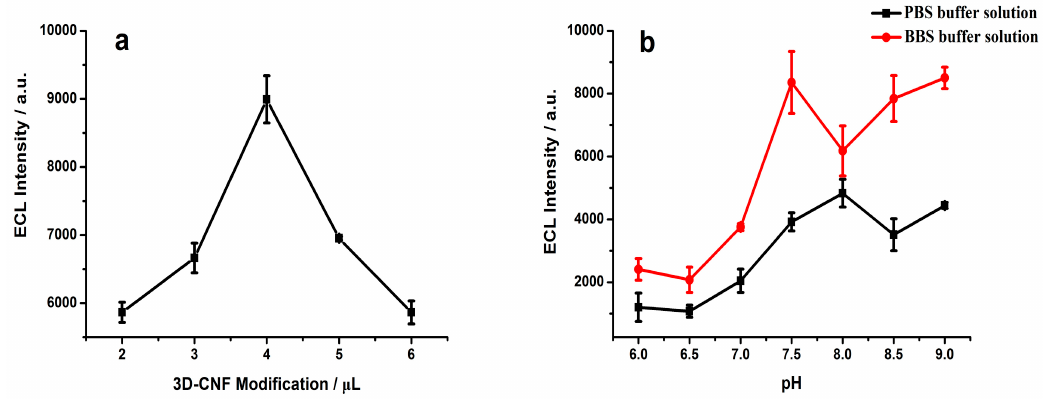
Figure 5. Optimization of detection conditions: ( a ) volume of 3D-CNFs; ( b ) buffer type and pH value. A 0.1-M BBS solution was used (pH = 7.5; with a concentration of 3 × 10 − 5 mol·L − 1 of difenidol hydrochloride). Error bar: standard deviation for n = 3. PBS:phosphate buffer solution ; BBS: borate buffer solution .